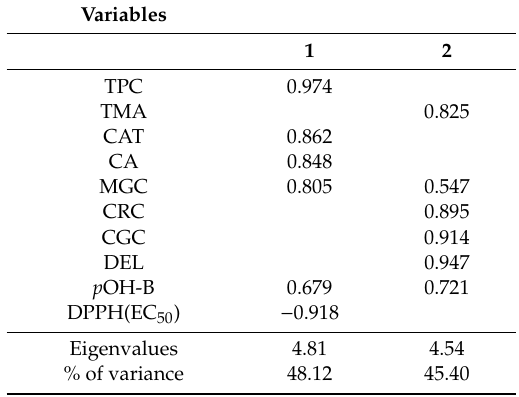
Table 3. Loadings of the significant measured variables on the three first principal components (PCs) *. Variables